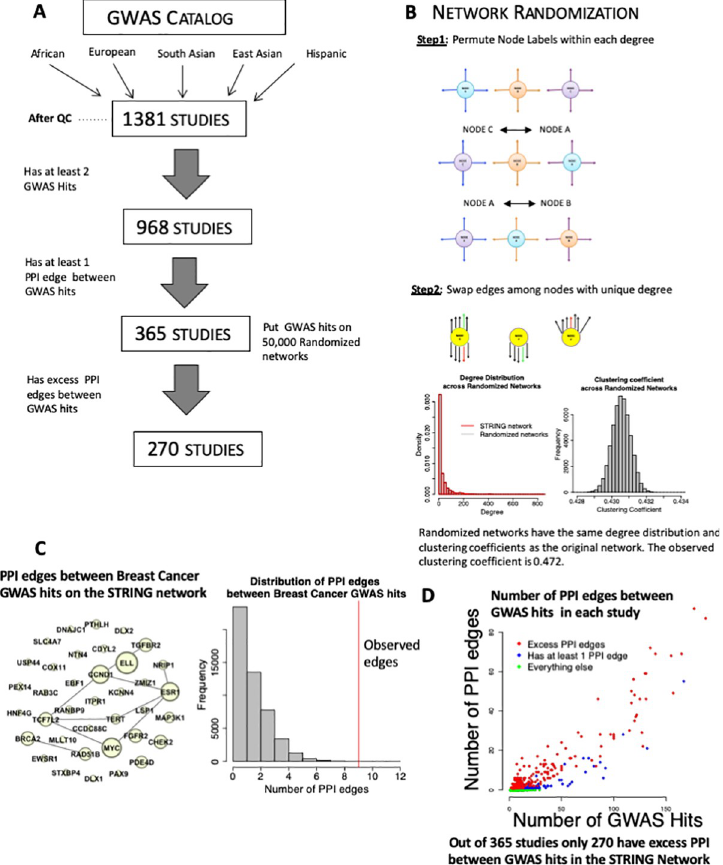
Fig 1. Identifying studies with excess PPI amongst GWAS hits. (A) A subset of GWAS studies had excess protein- protein interactions amongst their GWAS hits. 1,381 GWAS studies were obtained from the GWAS catalog, of these 968 had at least 2 GWAS hits and 365 studies had at least 1 PPI edge between GWAS hits. Out of these 365 studies, 270 studies had more PPI edges between their GWAS hits than expected by chance. (B) (top) Schematic of our procedure for randomizing networks. We implemented the method from [27]. To maintain topology, randomized networks were created by swapping labels among nodes with the same degree and swapping edges among nodes with unique degree. (bottom) Degree distribution and distribution of clustering coefficients across 50,000 randomized networks. (C) (left) Illustrative GWAS study (Breast Cancer risk, (GCST001937)) with 37 GWAS hits, and 9 PPI edges between GWAS hits. The size of each node denotes its degree, and edges between nodes indication PP interactions. (right) Results of permutation testing reveals that the observed 9 PPI edges between the 37 GWAS hits is in excess of the expected number of PPI edges obtained from 50,000 randomized networks. (D) In blue are the 365 GWAS studies with at least 1 PPI amongst their GWAS hits, in red are the 270 studies with more PPI amongst their GWAS hits than expected by chance (FDR <